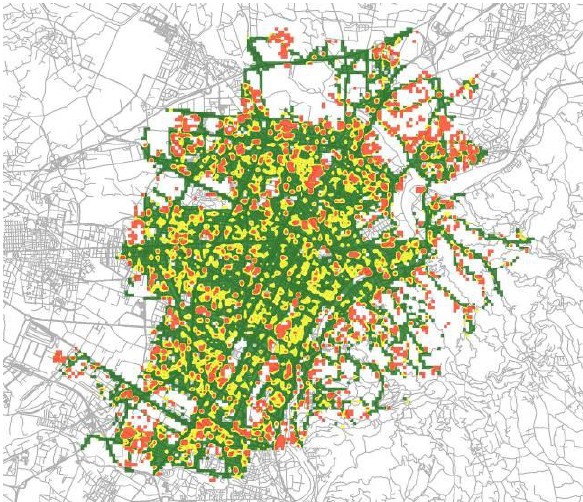
Figure 4. Mean distance between each single FCD and the nearest OTM network element (green = 0-7 m, yellow = 7-13 m,